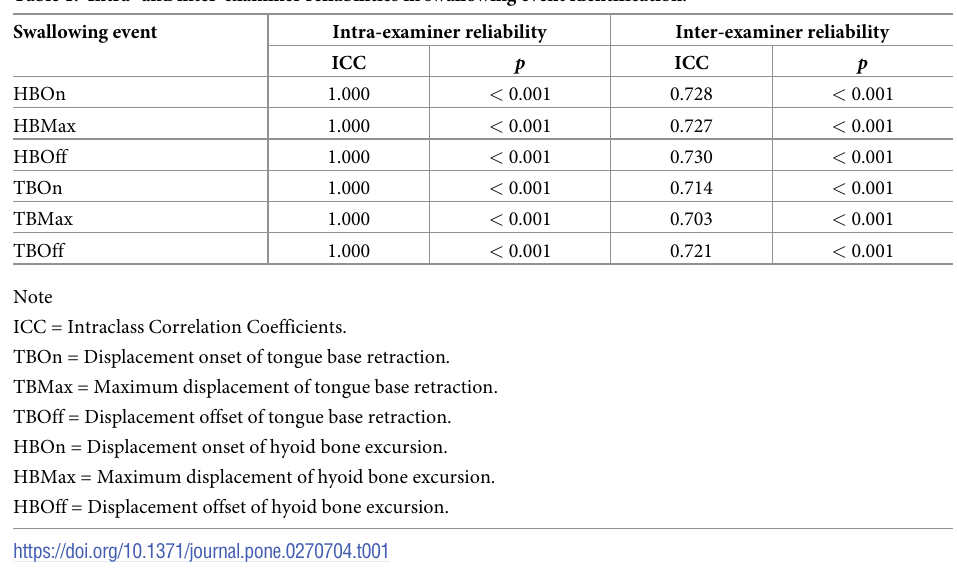
Table 1. Intra- and inter-examiner reliabilities in swallowing event